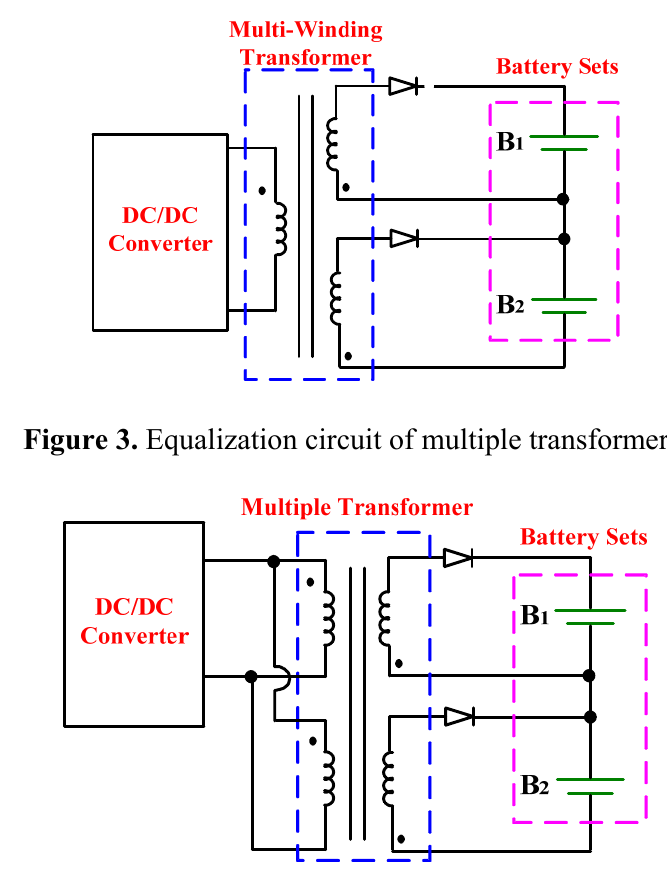
Figure 2. Equalization circuit of multi-winding transformer.